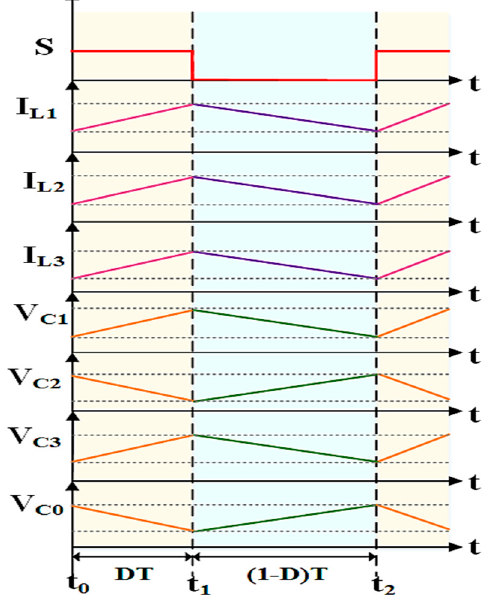
Figure 4. Theoretical waveforms of the proposed HG-SIQBC. (Ton and Toff are differentiated with dotted lines with pink and blue backgrounds respectively)